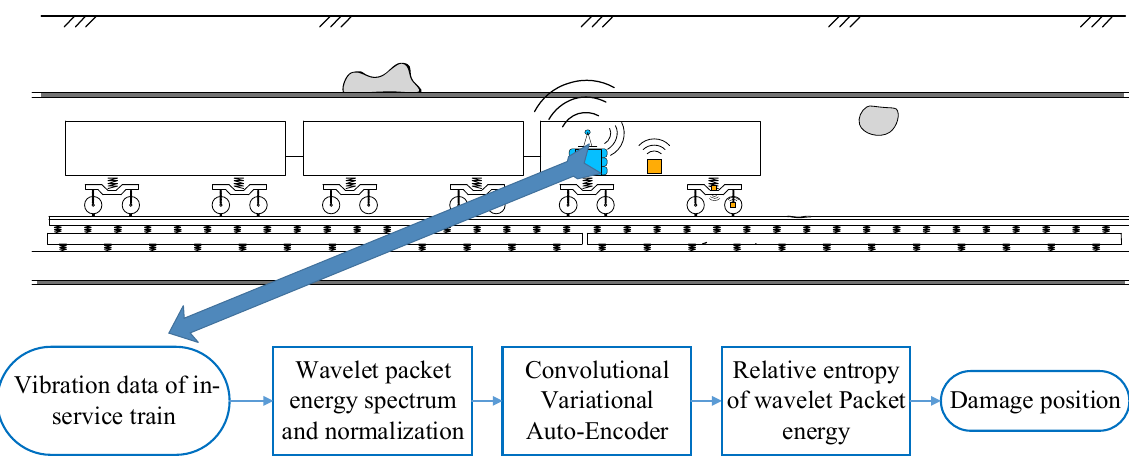
Figure 1. The proposed tunnel damage detection method.